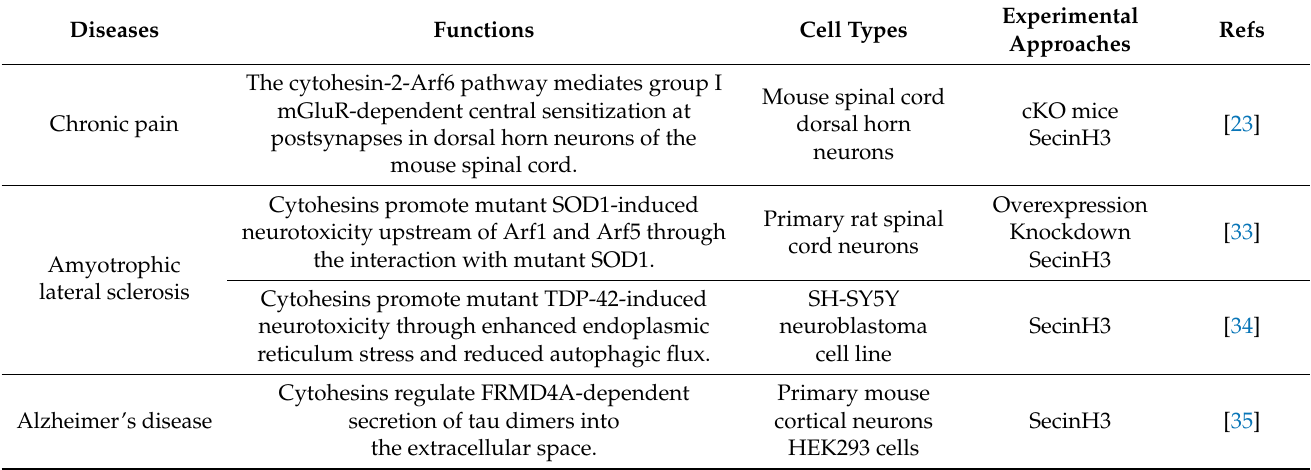
Table 3. Summary of the roles of cytohesins in neurological